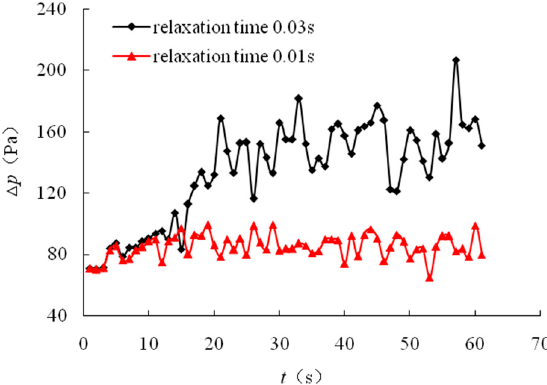
Figure 11. Displacement pressure drop vs. time for different elastic polymer solutions.